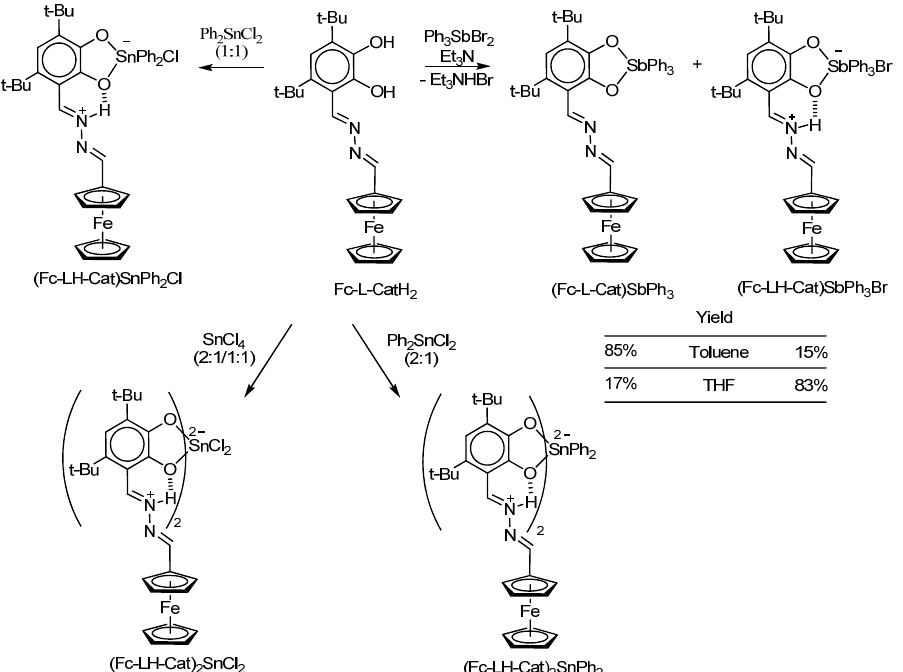
Scheme 17. Synthesis of antimony(V) and tin(IV) complexes based on the ferrocene-containing cat- echol Fc-L-CatH 2